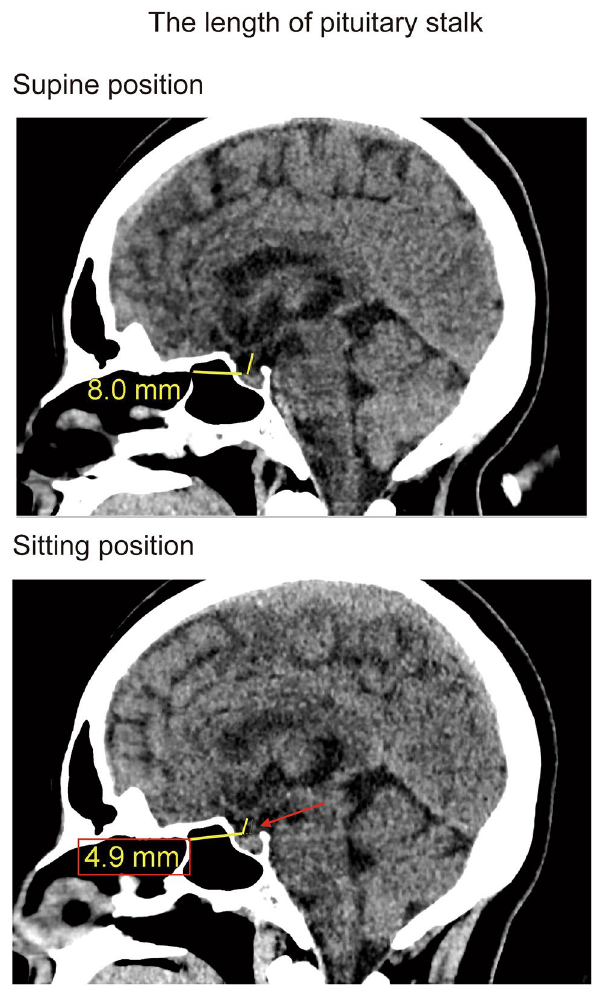
Figure 2. The length of pituitary stalk in supine (upper image) and sitting position (under image). The pituitary stalk shortened in sitting position (red arrow in sitting